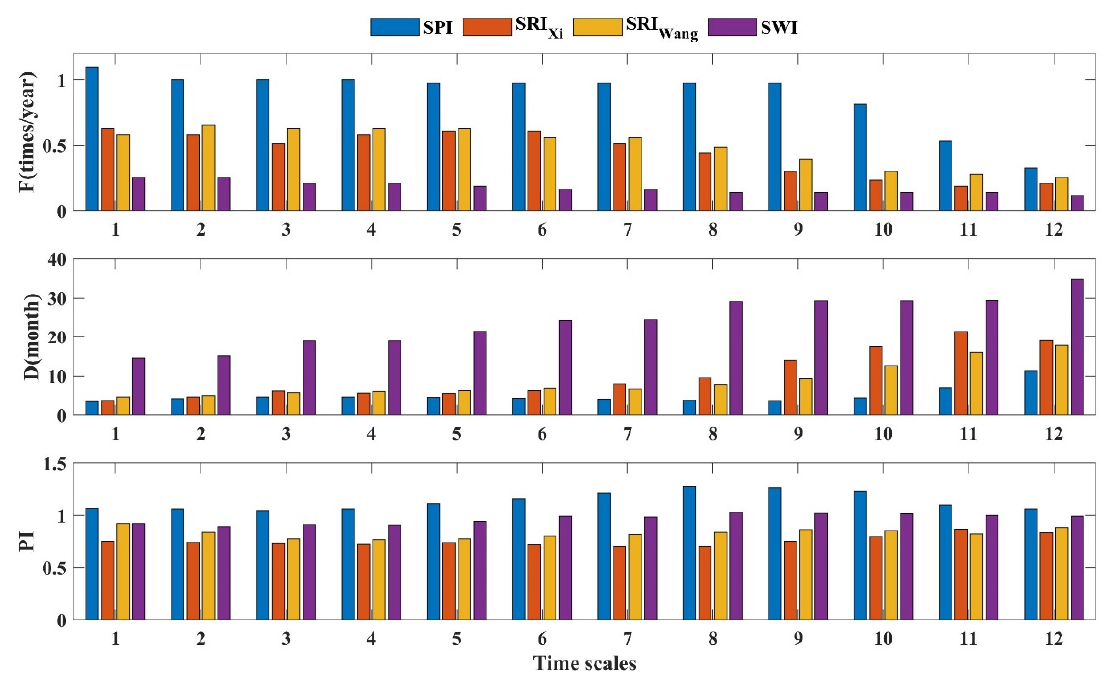
Figure 9. Drought characteristics of the SPI, SRI Xi , SRI Wang , and SWI at different timescales after a changing environment (PI denotes the absolute values).